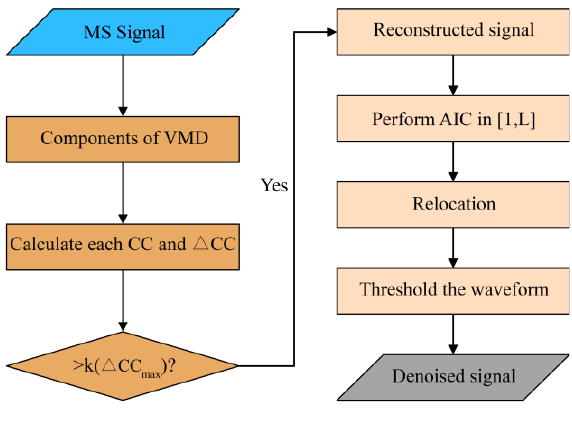
Figure 2. The VMD-AIC algorithm flow chart.